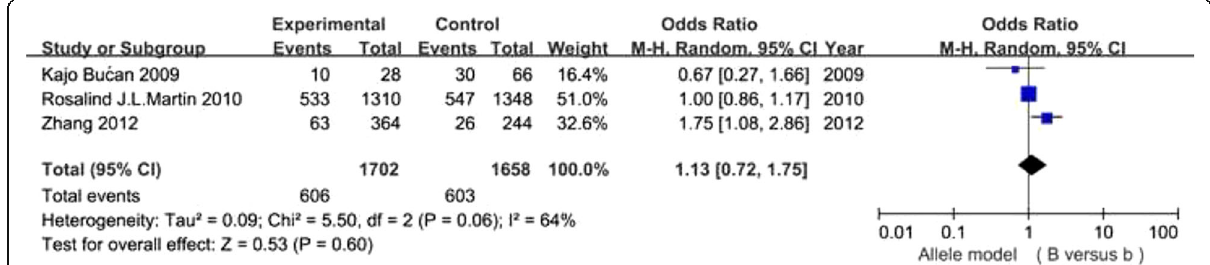
Fig. 2 Association of VDR BsmI gene polymorphism(B vs b)with DN susceptibility in overall populations